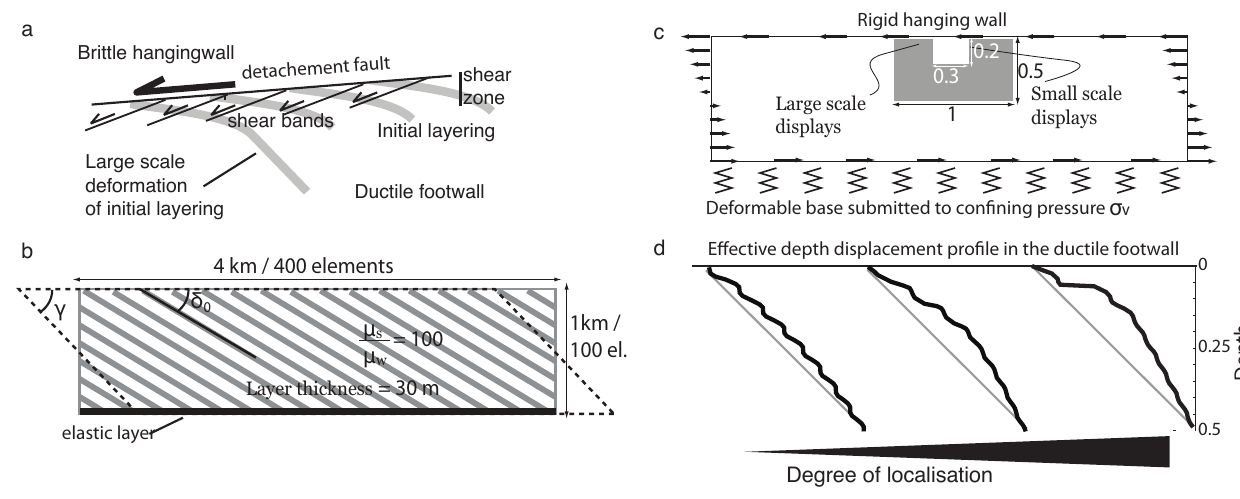
Fig. 1. (a) Sketch of a detachment fault separating a brittle upper crust (not modelled here) from the ductile footwall exhibiting a mechanical layering (grey lines). At large scale the deformation is localised close to the detachment, with a specific downward penetration. Within this zone, the initial layering is crosscut by shear bands at small scale. (b) Model set up with initial layering (grey and white layers) dipping at an angle δ 0 . Note that an elastic layer has been placed at the base of the model. (c) Sketch of the boundary conditions with boxes representing the part of models represented in the subsequent figures. Confining pressure is applied on the elastic layer to avoid large pressure jumps between weak and strong layers at their base. (d) depth/displacement profiles are used to estimate the degree of strain localisation at large